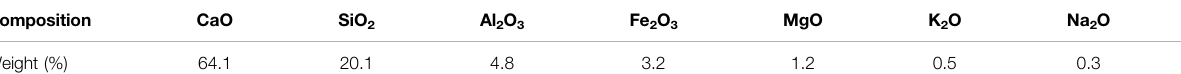
TABLE 1 | Chemical composition of Portland cement.